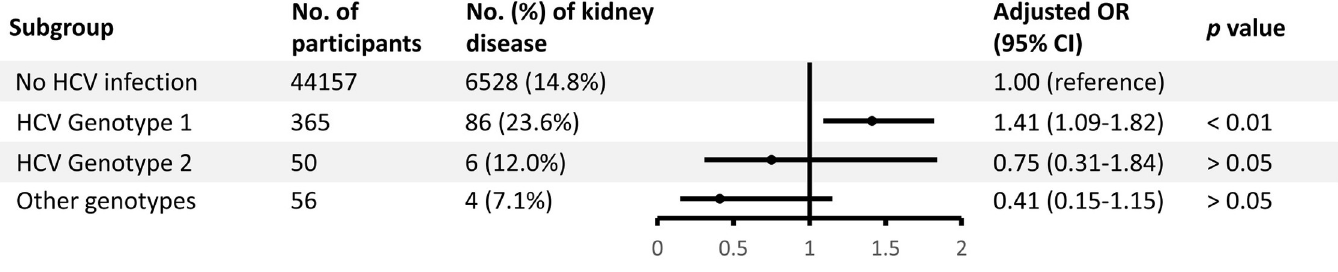
Fig 2. Hepatitis C virus (HCV) genotype 1 correlated to increased kidney disease risk. Compared with no HCV infection, we showed that HCV genotype 1 but not genotype 2 or other genotypes correlated to increased kidney disease risk after adjusted for age, sex, self-identified race/ethnicity (Blacks or non-Blacks), body mass index (BMI), diabetes, hypertension, cardiovascular disease, previous stroke, and human immunodeficiency virus (HIV) infection.